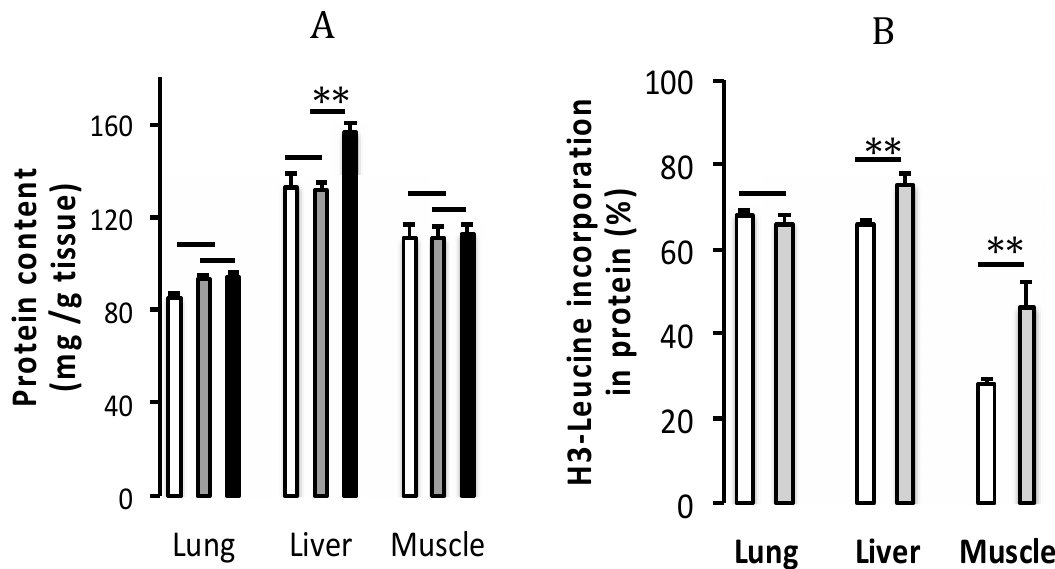
Figure 4. Protein content and index of protein synthesis. ( A ) Protein content (mg / g of tissue) and ( B ) index of protein synthesis (% of H 3 -leucine in the protein fraction) in lungs, liver and gastrocnemius muscle. White column: PN (Parenteral nutrition). Gray column: PN + 10 µ M GSSG. Black column: Reference group (animals fed orally). Data are expressed as mean ± S.E.M., n = 7–8 per group. The bars show the statistical comparisons. The absence of a symbol on the bar means that p > 0.05. **: p < 0.01.